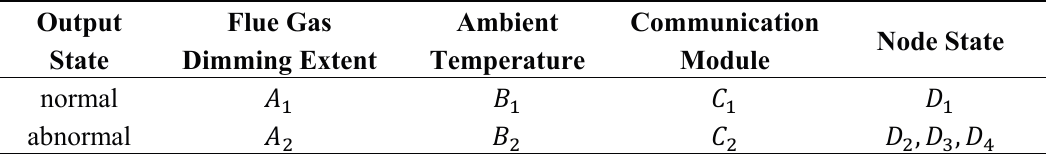
Table 1. Single node state fuzzy